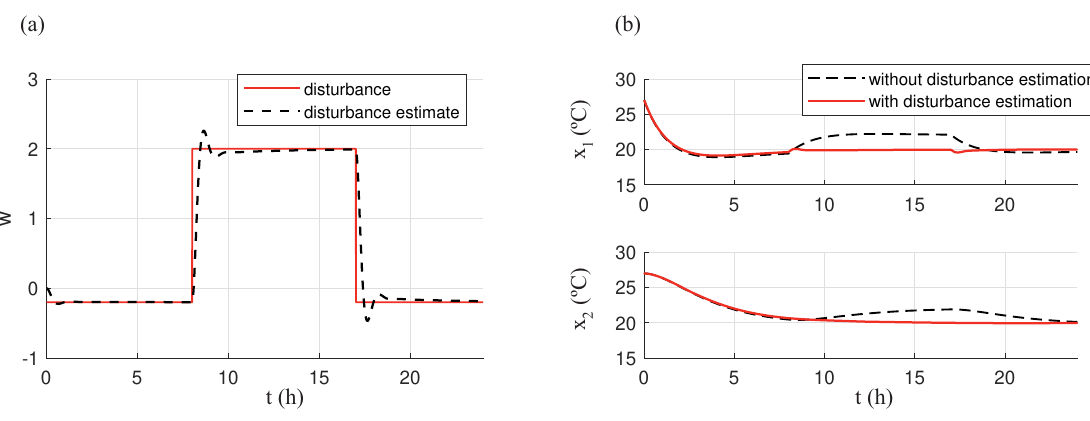
Figure 1. The disturbance (a) and state variables (b) for system (21).